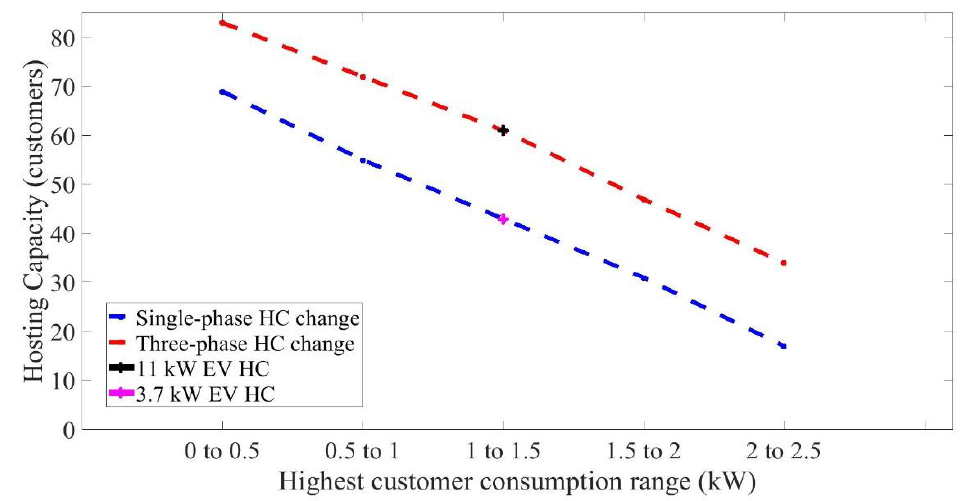
Figure 9. The 83-customers distribution network three-phase hosting capacity for EV charging power 11, 13.8, 17.25, 24.15, 27.6 and 34.5 kW. 11, 13.8, 17.25, 24.15, 27.6 and 34.5 kW.